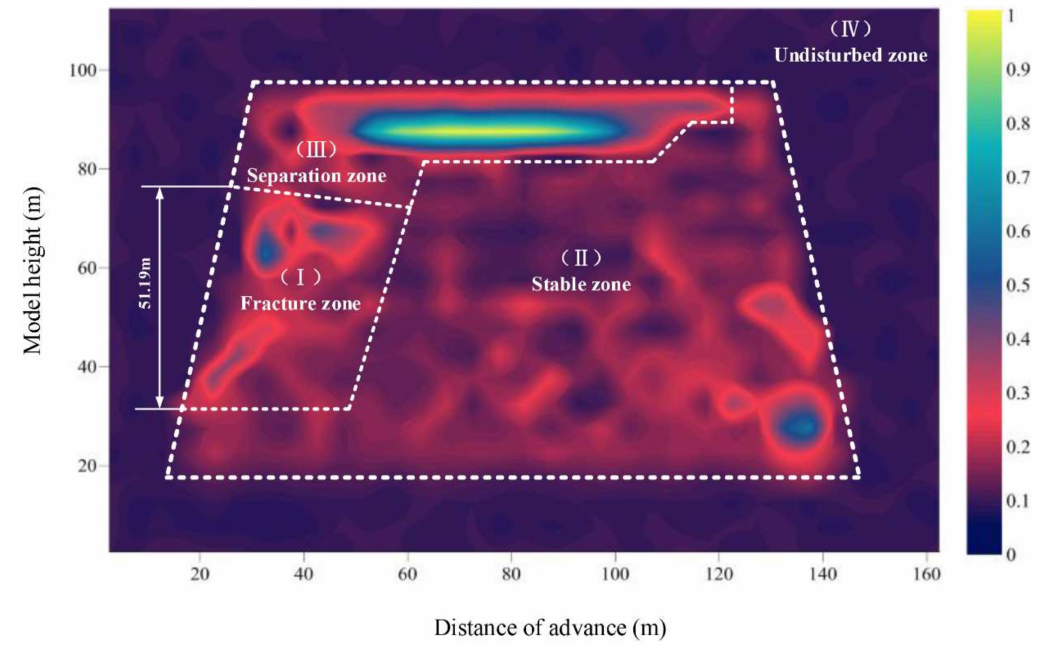
Figure 11. The gas-guiding fracture zone at 122 m prior to the working face can be divided by PFC 2D simulated porosity distribution data into four zones: fracture development zone ( I ), stability zone ( II ), stratification zone ( III ), and undisturbed zone ( IV ). The fissure development zone of 51.19 in height includes the caving-in zone and the mining- induced fracture